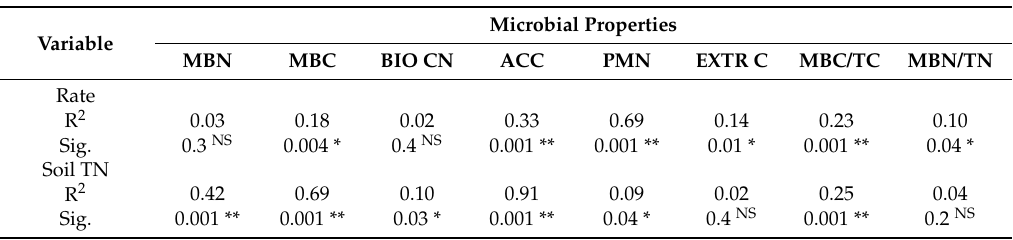
Table 3. Summary of forward step-wise regression analysis between rates of fertilizer application, soil TN and soil microbial properties ( n =